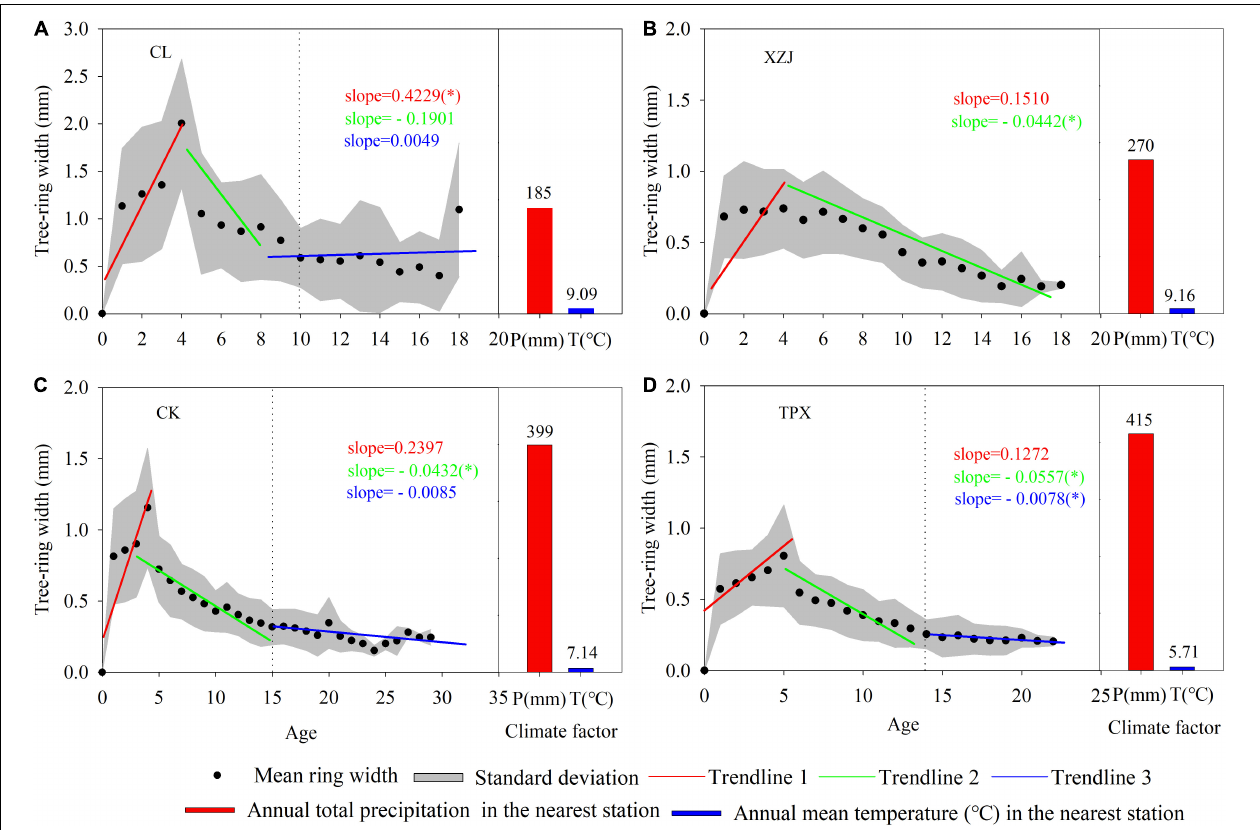
FIGURE 2 | Scatter plots of C. korshinskii radial growth corresponding to the tree age and segmented fits as well as climate graphs at each sampling site. Each linear dynamic slope is marked in the same color as the corresponding trendline (Significance: * p < 0.05). (A) CL, (B) XZJ, (C) , CK, and (D) TPX.